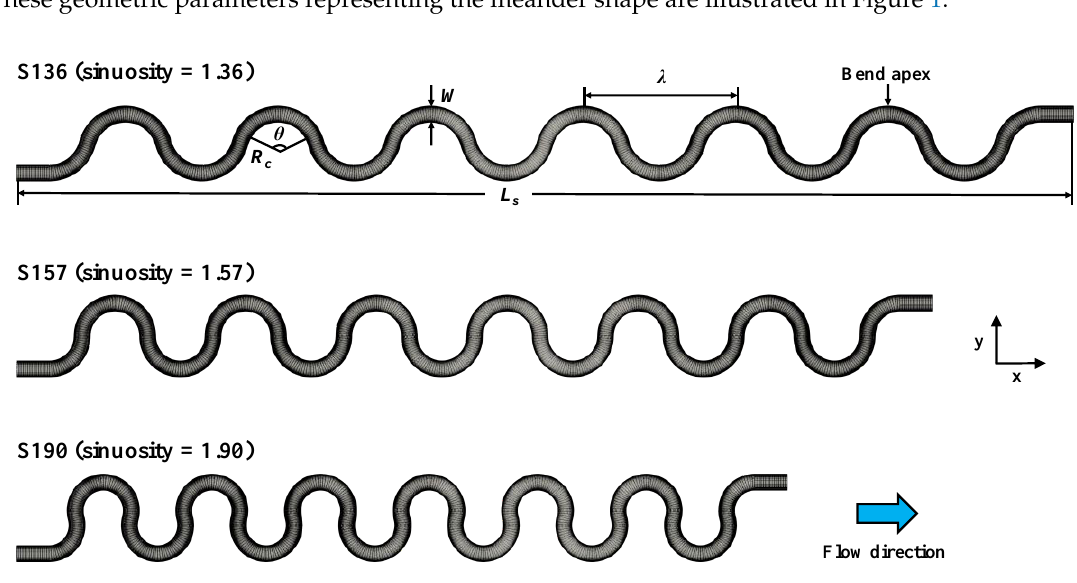
Figure 1. Channel geometries generated by Hey’s relations and corresponding computational grids for simulation cases with different sinuosity levels.